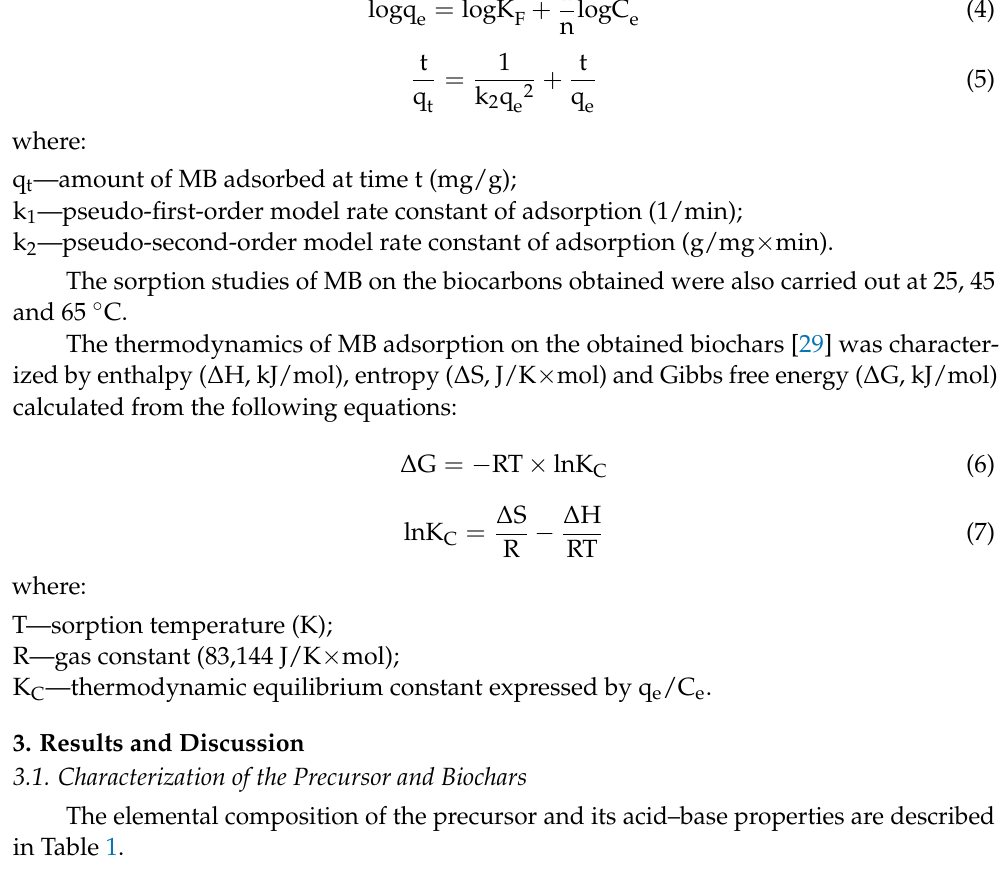
Table 1. Characterization of the